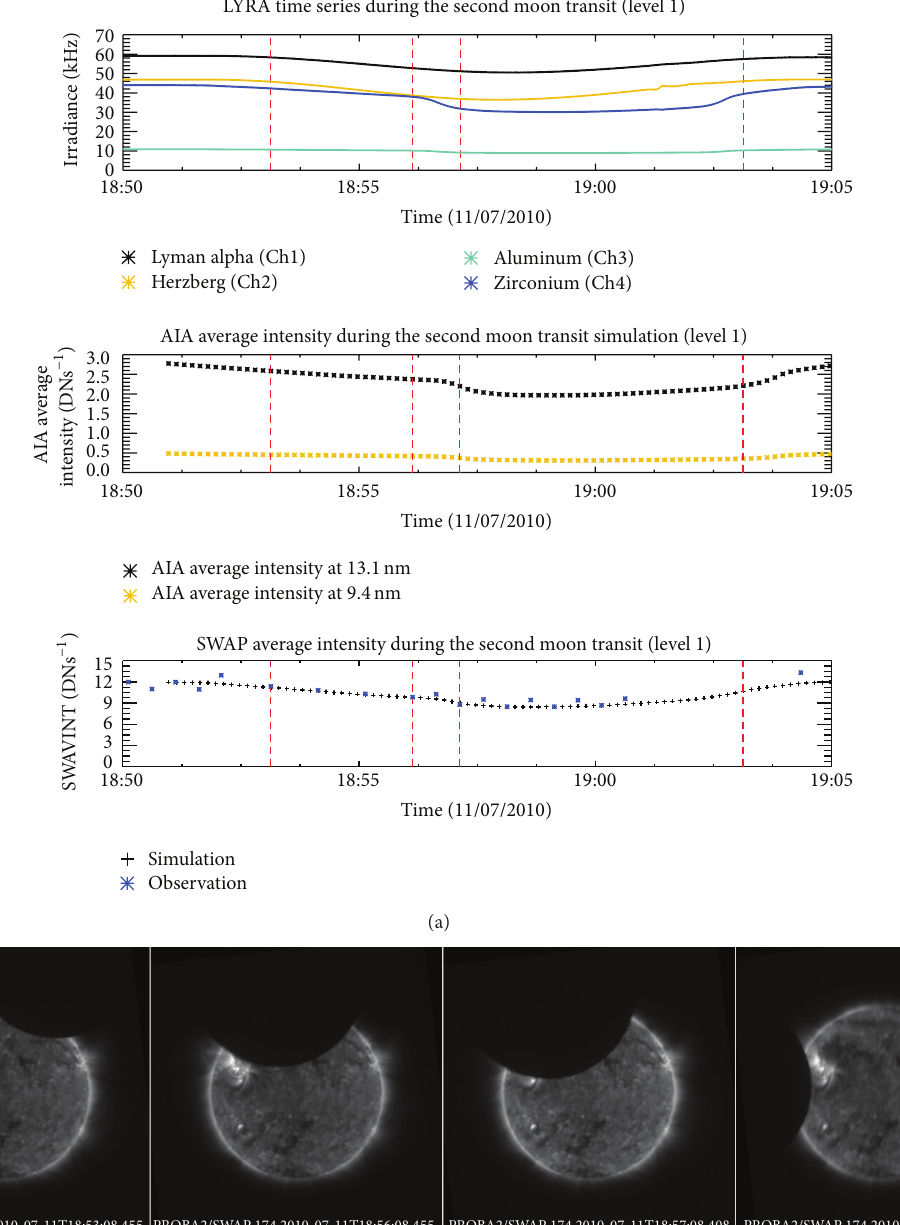
Figure 9: LYRA level 1 data measured by all four channels of unit 2, measured and simulated SWAVINT, and simulated AIA average intensity variations during the second transit of the Moon (a) together with certain SWAP images taken during the second transit of the Moon (b) whose times of observation are indicated in vertical lines on the